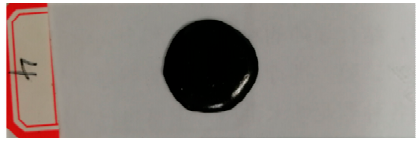
Figure 5. AFM Figure 5. AFM samples.